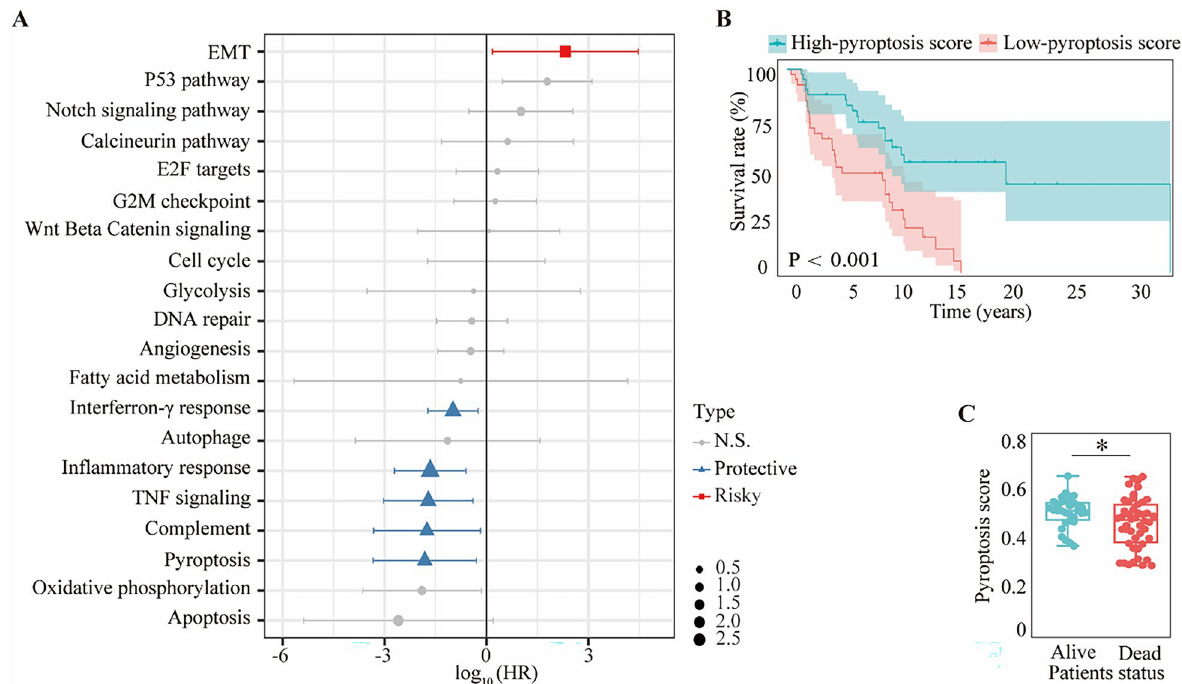
Figure 1. Pyroptosis is related to melanoma overall survival (OS). ( A ) Hazard ratio (HR) for each of 20 cancer hallmarks of prognosis on a forest plot. ( B ) Kaplan–Meier OS curves for melanoma patients with high and low pyroptosis scores. ( C ) Comparison of pyroptosis scores in living and dead melanoma patients. Statistical analysis: * p < 0.05. This figure was created using R software version 4.0.3 32 (https:// www.r- proje ct.